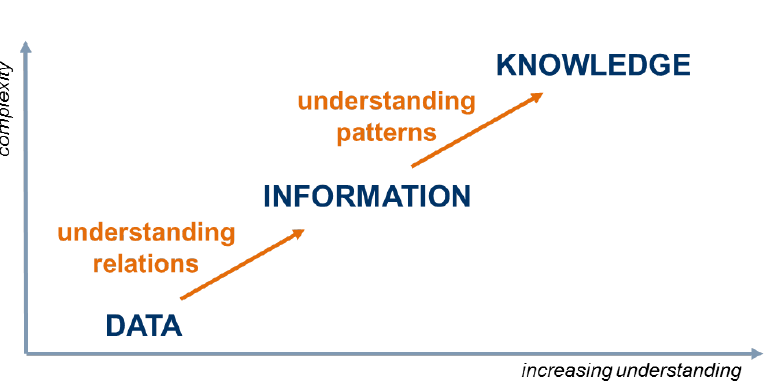
Figure 1. From data to